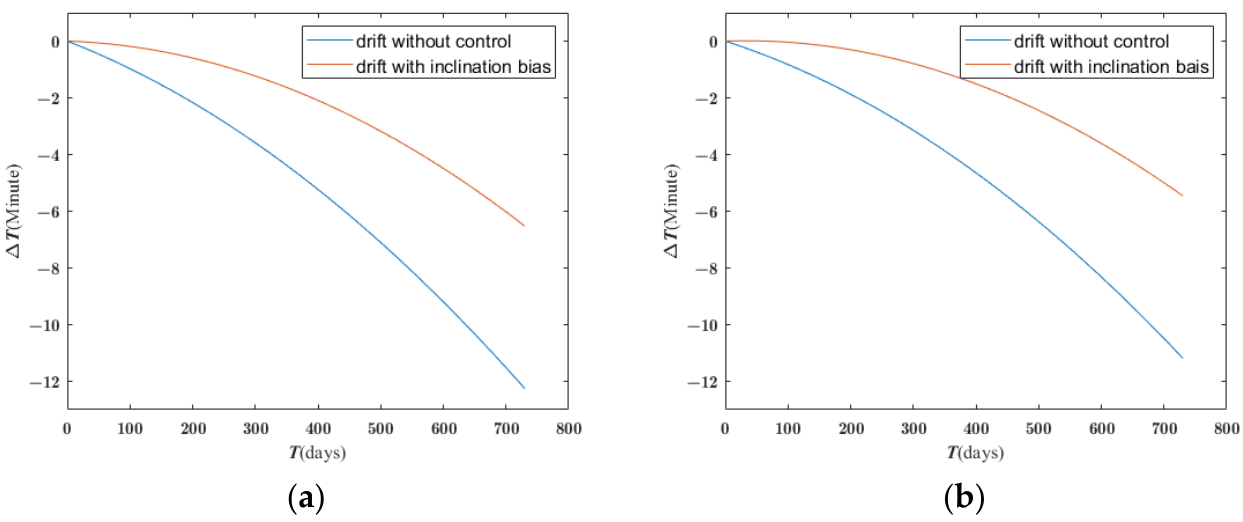
ˆ T  Figure 3. A comparison between ∆ T values considered solar gravitation and ∆ ˆ T simulating the solar Figure 3. A comparison between T  values considered solar gravitation and simulating the gravitation with a preset inclination in 2 Earth years for − ( β s − Ω ) = − 45 deg. ( a ) ∆ a 0 = 0.5 km, solar gravitation with a preset inclination in 2 Earth years for ∆ i = 1 × 10 − 5 deg; ( b ) ∆ a = 0.5 km, ∆ i = 2 × 10 − 3 deg. 0 0 0 The multiple inclination bias method utilizes a periodic inclination bias to reduce the ) / ( d i /d t ) , the local time drift caused by solar gravitation. In a period of t c = − 2 ∆ i ( t c 0 extremum of local time drift is equal to a fixed local time drift-bound ∆ (cid:101) T